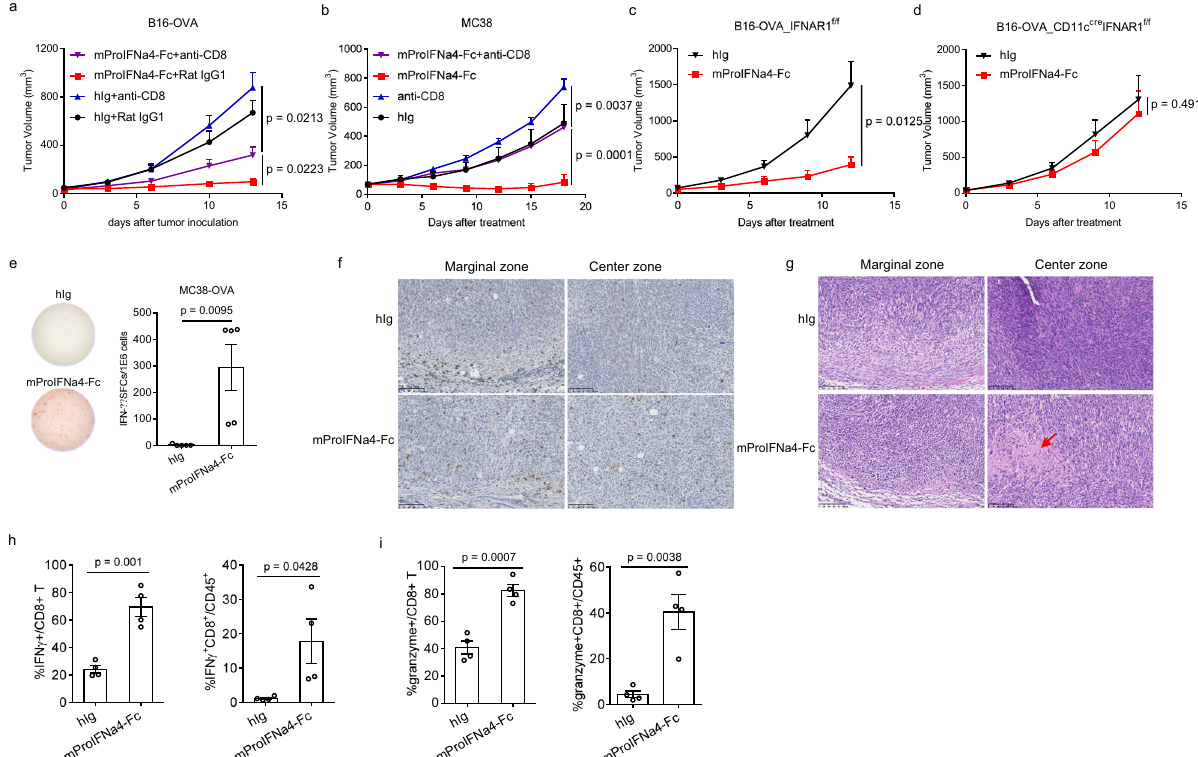
Fig. 4 Dendritic cells and cytotoxic T cells are required for ProIFN-mediated tumor regression. a C57BL/6 J mice were s.c. inoculated with 5 × 10 5 B16- OVA tumor cells and i.p. treated with 1 nmol of the fusion protein on day 8, 11, and 14 ( n = 5 animals). 200 μ g anti-CD8 was administrated on day 8, 11, and 18. Tumor growth was shown. b C57BL/6 J mice were s.c. inoculated with 1 × 10 6 MC38 tumor cells and i.p. treated with 1 nmol of the fusion protein on day 9, 12, and 15 ( n = 5 animals). 200 μ g anti-CD8 was administrated on day 9, 12, and 19. Tumor growth was shown. c IFNAR1 f/f mice were s.c. inoculated with 5 × 10 5 B16-OVA tumor cells and i.p. treated with 0.2 nmol of hIg or mProIFNa4-Fc on day 8, 11, and 14. Tumor growth was shown ( n = 7 animals). d CD11c cre IFNAR1 f/f mice were s.c. inoculated with 5 × 10 5 B16-OVA tumor cells and i.p. treated with 0.2 nmol of hIg, or mProIFNa4-Fc, on day 8, 11, and 14. Tumor growth was shown ( n = 8 animals). e MC38-OVA tumor-bearing C57BL/6 mice ( n = 5 animals) were i.p. treated with 1 nmol of hIg or mProIFNa4- Fc on day 14 and 17. Two days after the last treatment, DCs were isolated and co-cultured with isolated OT-I transgenic CD8 + T cells. Forty-eight hours later, IFN- γ -producing cells were enumerated by ELISPOT assay. f , g C57BL/6 J mice were s.c. inoculated with 1 × 10 6 MC38 tumor cells and i.p. treated with 1 nmol of hIg or mProIFNa4-Fc on day 10 and 13. Tumor tissues were harvested 4 days after the last treatment. CD8 + IHC ( f ) and HE ( g ) staining were performed. Red arrow in the ( g ) showed the apoptosis area. The maximum unit of the scale bar is 100 µ m. The images are representative of four mice samples in each group. The experiment was repeated two times independently with similar results. h To assess the IFN- γ producing ability of T cells, B16 tumor-bearing IFN- γ YFP reporter mice ( n = 4 animals) were i.p. treated with 1 nmol of mProIFNa4-Fc on day 11, 14, and 17. Two days after the last treatment, tumor tissues were harvested and YFP + CD8 + T cells were determined by fl ow cytometry. i B16 tumor-bearing WT mice ( n = 4 animals)